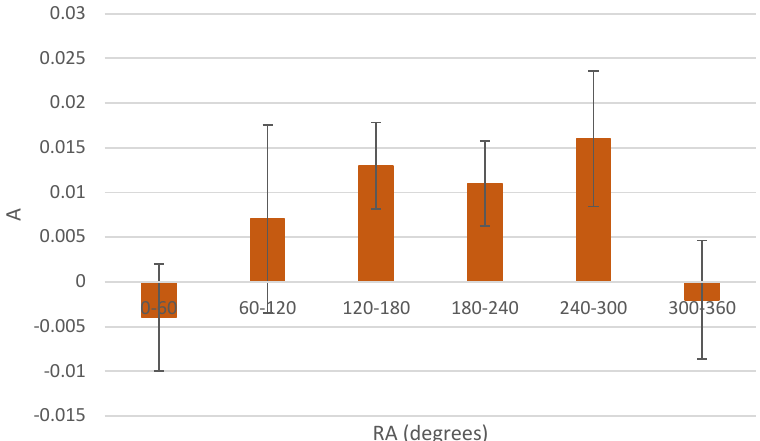
Figure 11. The asymmetry between the number of clockwise and counterclockwise galaxies in different RA ranges such that each galaxy in the dataset is duplicated.